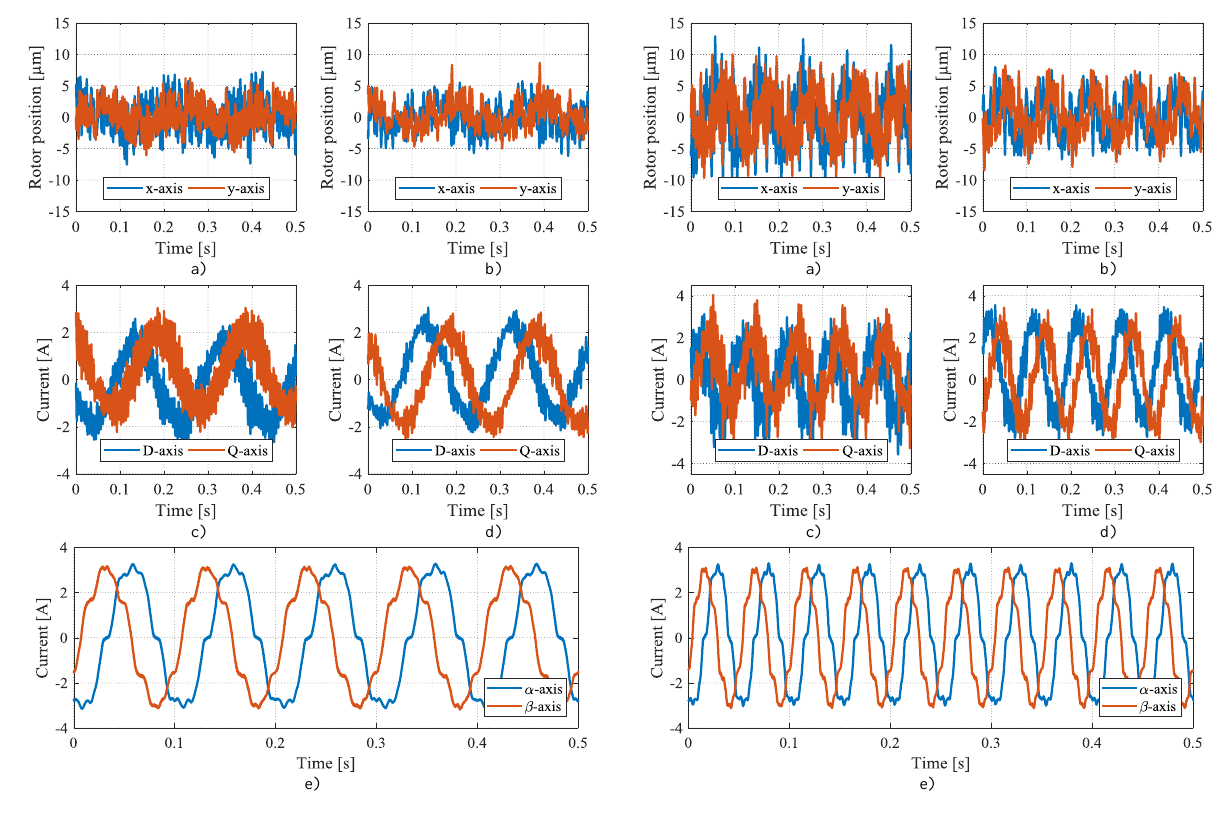
Figure 14: Rotation test with speed of 300 r/min. Mea- sured rotor position is shown for D-end and ND-end in a) and b), respectively. Levita- tion winding current for D-end and ND-end is shown in c) and d). respectively.